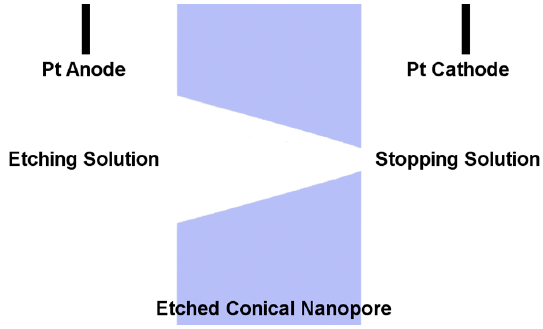
Figure 2. Schematic illustration of a conical nanopore during etching. Dimensions are not to scale.